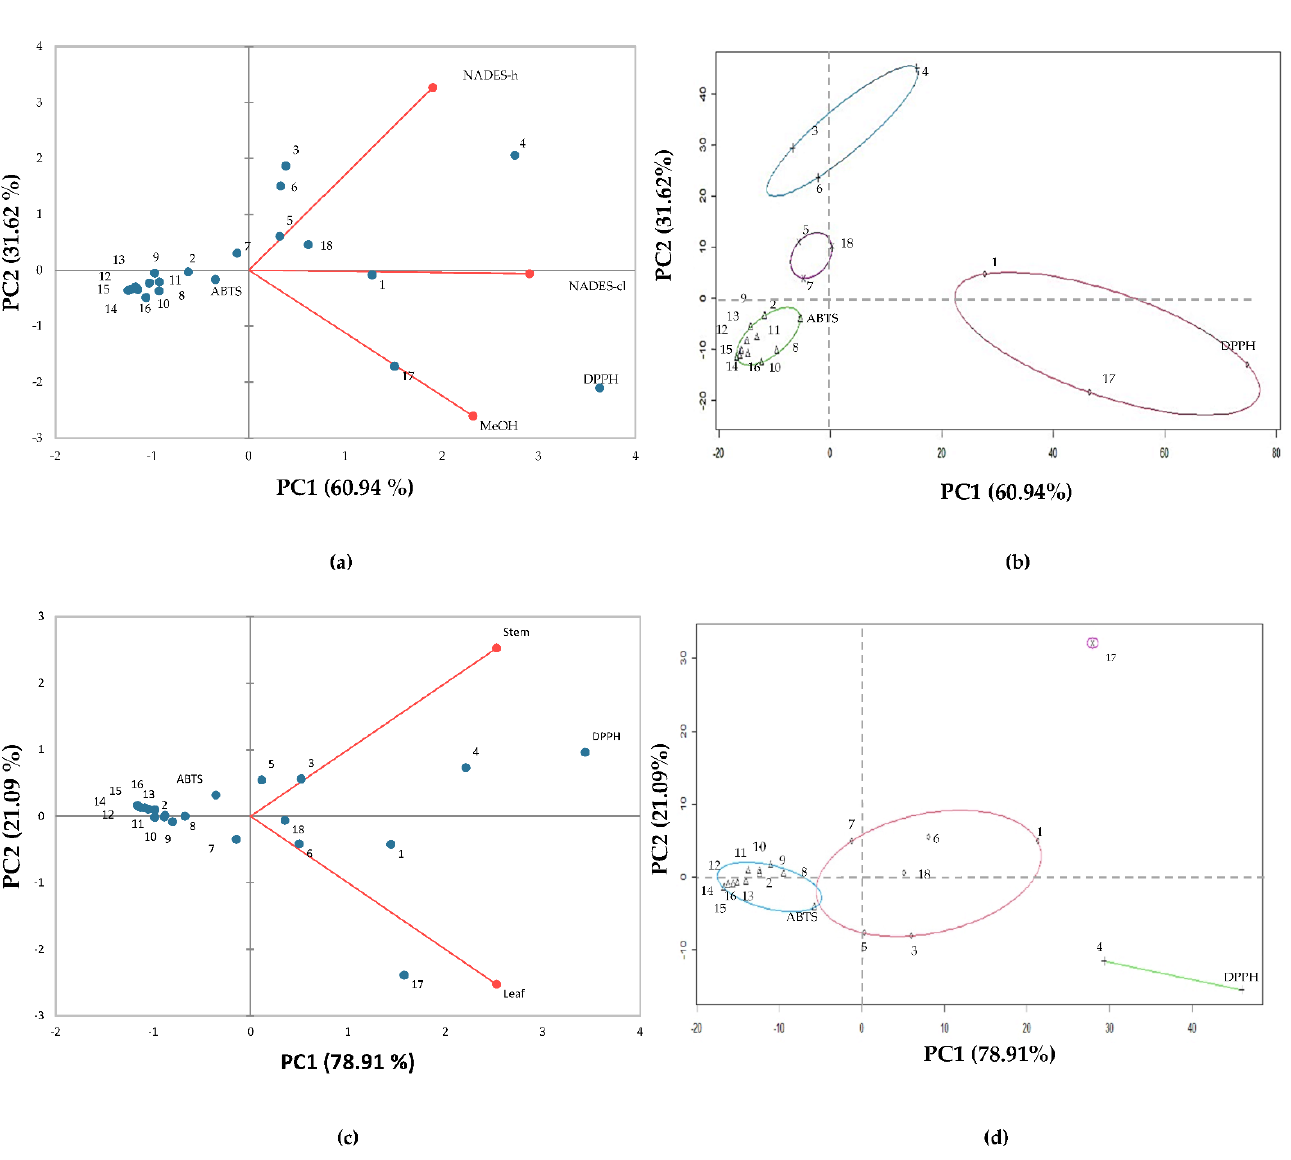
Figure 3. Analysis of total polyphenol content, polyphenol profile and antioxidant capacity: principal component analysis (PCA) depending on solvents ( a ) and by-product ( c ) used, and cluster of k means depending on solvents ( b ) and by-product ( d ) used. Numeration: 1 = total polyphenol content; 2 = gallic acid; 3 = protocatechuic acid; 4 = catechin; 5 = chlorogenic acid; 6 = quercetin + luteolin; 7 = rutin; 8 = kaempferol; 9 = neohesperidin; 10 = diosmetin; 11 = vanillin; 12 = coumaric acid; 13 = cinnamic acid; 14 = naringenin; 15 = apigenin; 16 = lutein, 17 = diosmin + hesperidin; 18 = vitamin C. Protocatechuic acid (3), catechin (4) and quercetin + luteolin (6) established a con- glomerate that may be associated more with NADES-h; meanwhile, total polyphenol con-